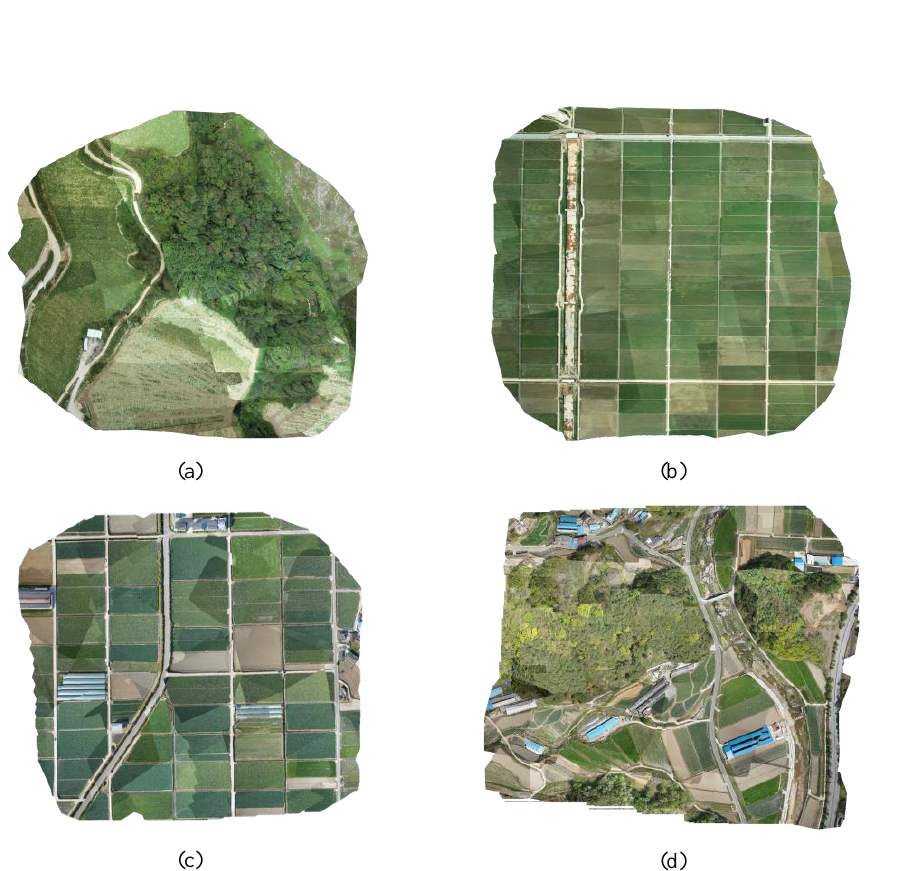
Figure 6. Mosaic images before applying the proposed